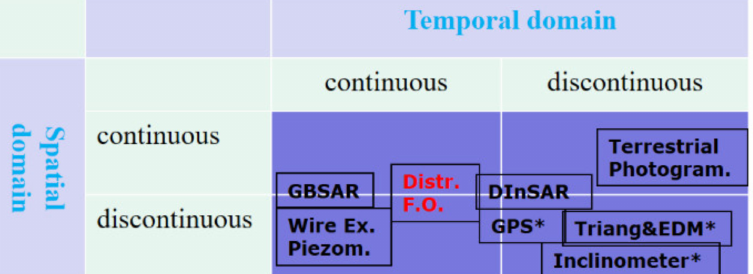
Figure 28. Tentative disposition of the different techniques as specifically used in Vallcebre: follow- ing [26], systems are classified according to their continuity in the Spatial and Temporal domain. Distributed Fiber Optics is in red because it has not yet been applied. The asterisks indicate that the technique, with a slightly different setup, may become continuous over space or